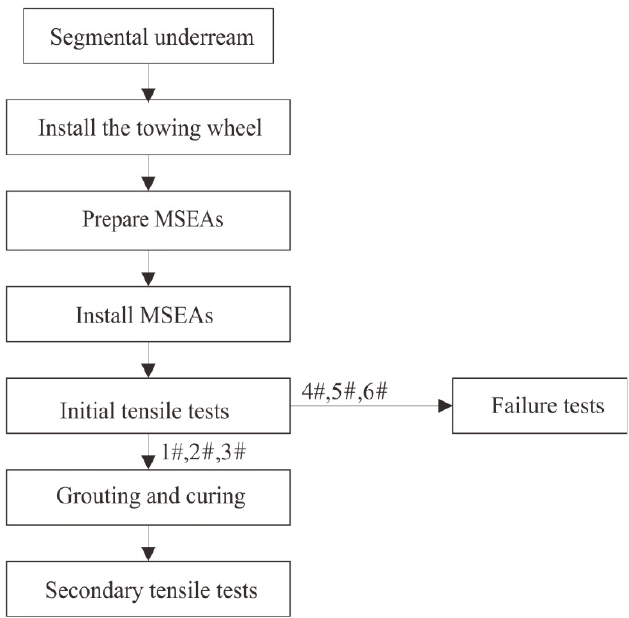
Figure 2. A schematic diagram of field tests.